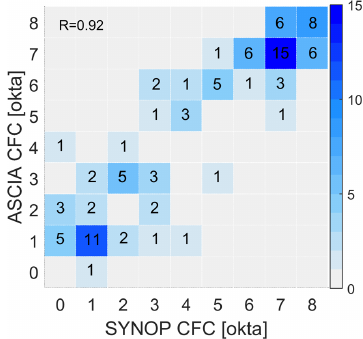
Figure 14. Density plot of occurrences of the CFC by ASCIA as a function of SYNOP.